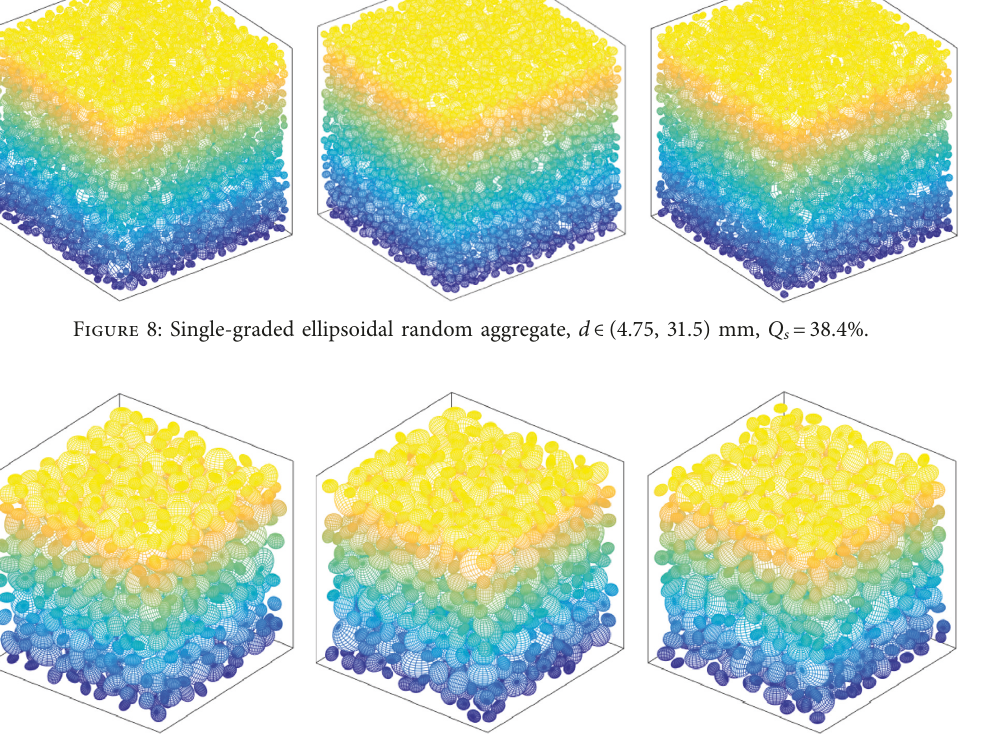
Figure 9: Continuous-graded ellipsoidal random